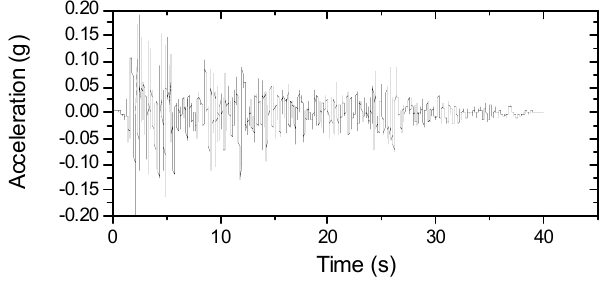
Figure 3. Adjusted El Centro Seismic Wave.